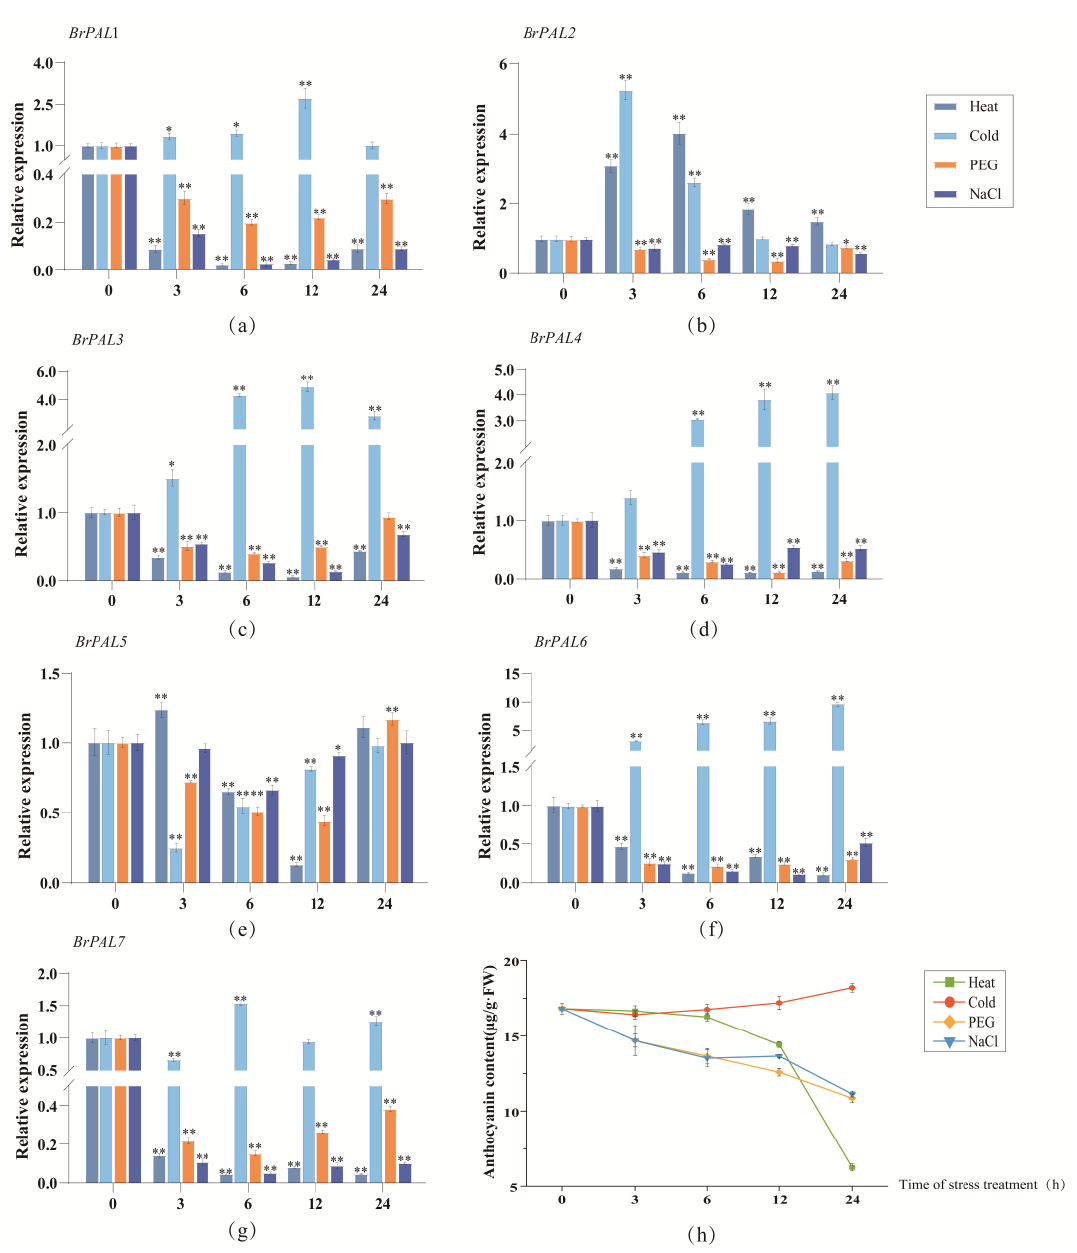
Figure 8. Relative expression level and anthocyanin content of BrPAL gene at 0, 3, 6, 12, 24 h under abiotic stress. ( a – g ) Histogram of relative expression of PAL gene in purple cabbage under high temperature, low temperature, drought, and salt stress; ( h ) line graph of anthocyanin content in purple cabbage under abiotic stress; Data represent the mean of triplicate with three biological replicates. * indicates significant difference ( p value < 0.05); ** indicates extremely significant difference ( p value < 0.01).